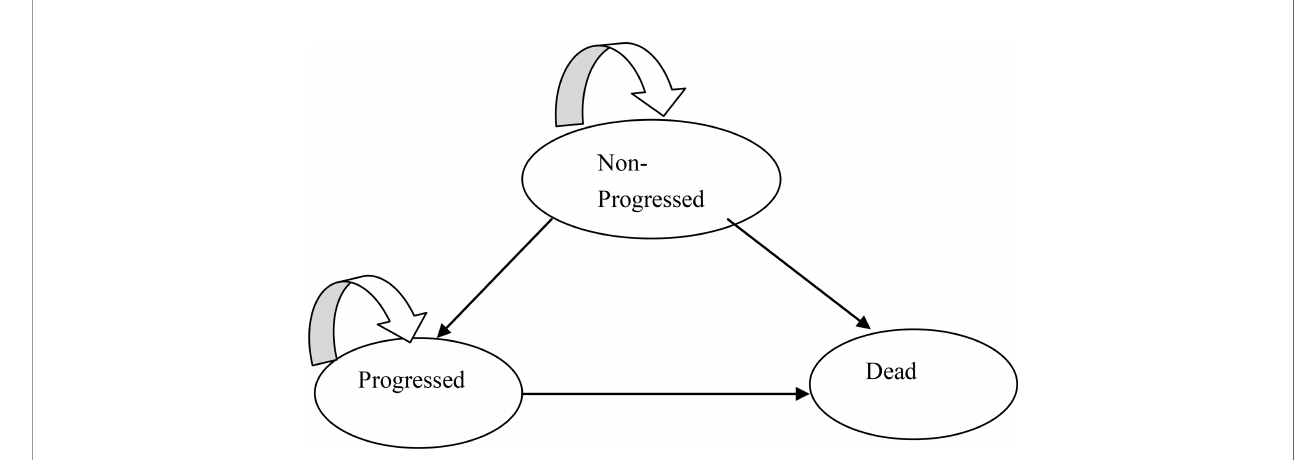
FIGURE 2 | Three main health states of partitioned survival